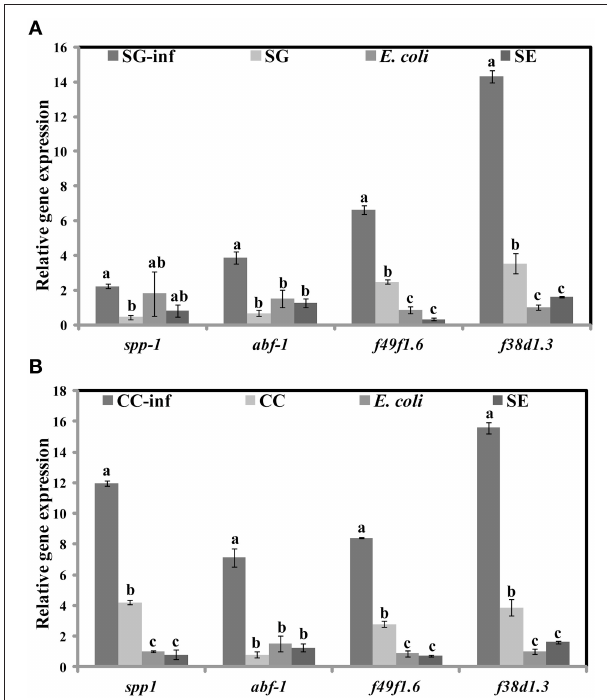
FIGURE 9 | Effect of SWE on the relative expression of immune responsive genes. Expression of the immune response genes spp-1 (saponin like protein), abf-1 (antibacterial protein), f49f1.6 (ShK domain-like, PMK-1) and f38a1.5 (lectin family protein) after 5 days of exposure to (A) SG or (B) CC was analyzed by quantitative reverse transcription PCR. SG - inf, C. elegans fed on SG and infected with S. Enteritidis; SG, C. elegans fed on SG; E. coli, C. elegans fed on heat killed E. coli ; SE, C. elegans fed on S. Enteritidis. Values with different superscript letters are significantly different (Tukey multiple mean comparison, p < 0.05). Values represent Mean ± Standard deviation from three independent experiments; each experiment had three biological